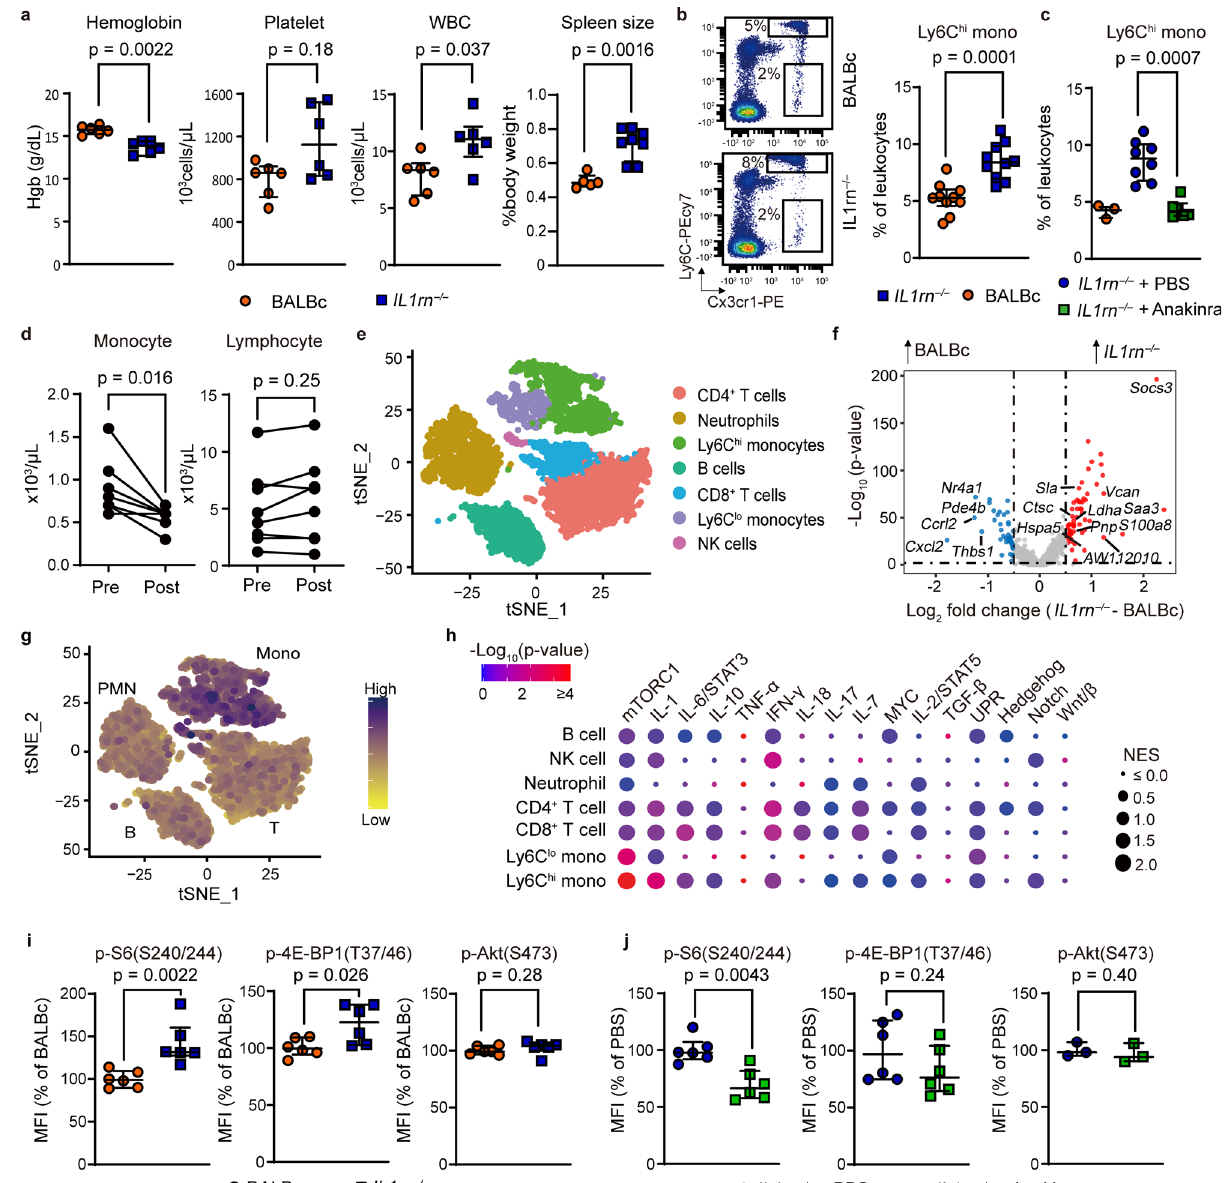
Fig. 1 | Monocytosis and enhanced mTORC1 signaling in IL-1-mediated in fl ammation.a CompletebloodcountinBALBc( n =5)andIL1rn − / − mice( n =6per group),and spleen sizein BALBc( n =6) and IL1rn − / − mice( n =8). b Flow cytometry quanti fi cation of circulating Ly6C hi monocytes in BALBc and IL1rn − / − mice at baseline( n =10pergroup) and ( c )afteranakinratreatment for2weeks(WT, n =3; IL1rn − / − PBS, n =8; IL1rn − / − +anakinra, n =6). d Peripheral blood monocyte and lymphocyte count in sJIA patients pre-treatment and 2 weeks after initiation of anakinra ( n =8). e t-SNE display of leukocyte clustering derived from single-cell RNA-seqofperipheralbloodcellsfromBALBcandIL1rn − / − mice(4micepooledper group). f VolcanoplotofdifferentiallyexpressedgenesinLy6C hi monocytesofWT and IL1rn − / − mice. g Density plot of Hallmark mTORC1 gene set expression using